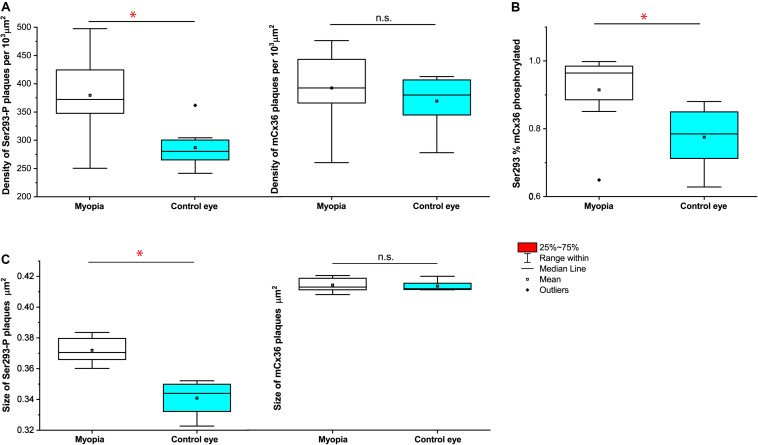
Quantification of phosphorylation of Cx36 gap junctions in AII amacrine cells in mouse myopic retinas. For S293, the density of phosphorylation reflected by detectable Ser293-P labeling (A), the percentage of Ser293-P of Cx36 phosphorylated rate (B), and the size of Ser293-P plaque (C) were significantly increased in myopic retinas compared to controls. The density of mCx36 labeling (A) and the size of mCx36 plaque (C) did not differ between myopic and control mouse retinas. The data are presented as averages. Error bars are SEM. Significance is based on Wilcoxon signed ranks test, where *0.01 < P < 0.05, not statistically significant P > 0.05.